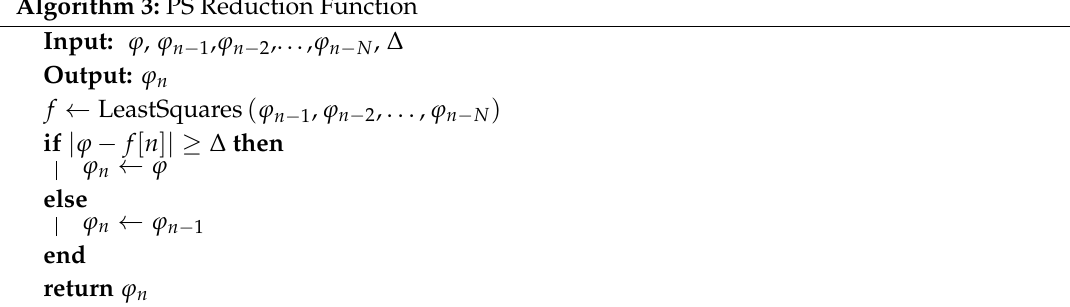
Algorithm 3: PS Reduction Function